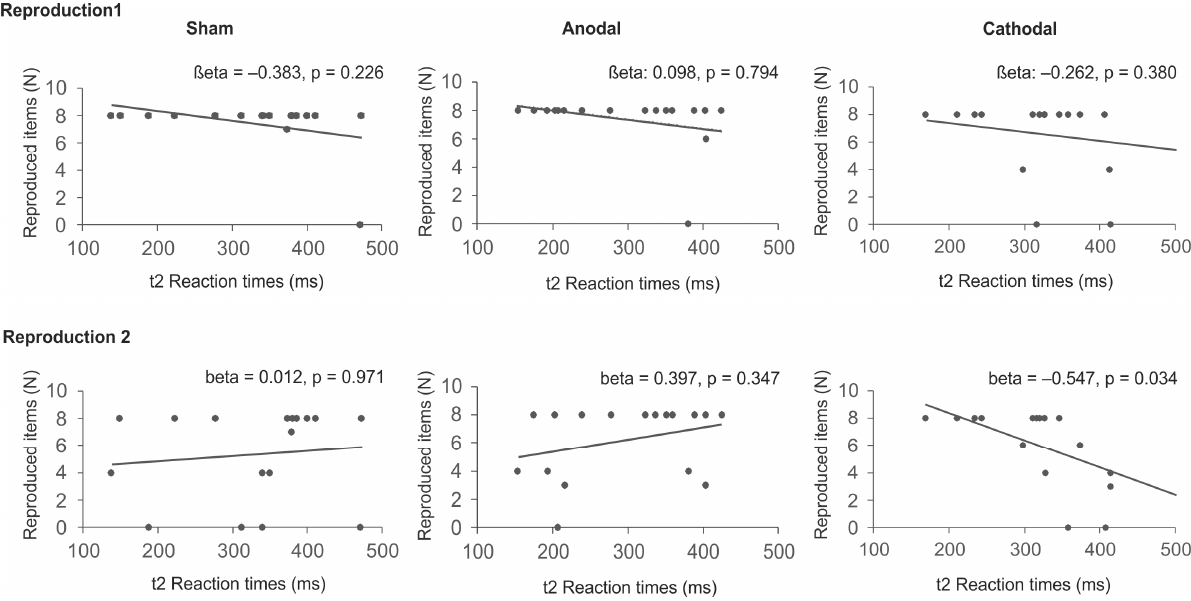
Figure 7. Regression analyses. Correlation between reaction times in sequential trials at t2 and the number of correctly reproduced items immediately after SRTT training (Reproduction 1) and after overnight sleep (Reproduction 2). The analyses suggest that following cathodal tDCS reaction times in sequential trials significantly predict explicit reproduction after sleep.